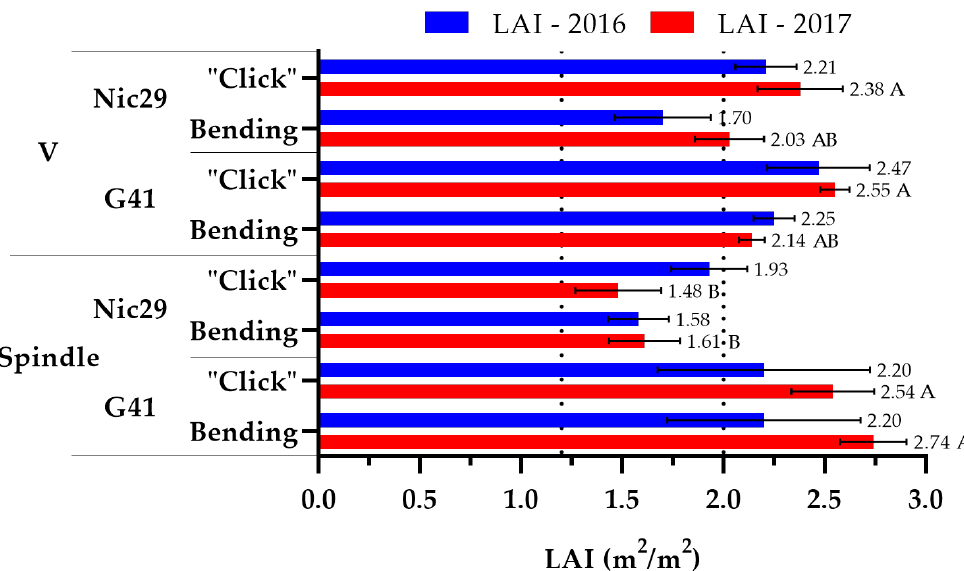
Figure 2. Average leaf area index (LAI) non-destructive estimations across all treatment combinations in the summers (June–August) 2016 and 2017 for “WA38” trees grown in Washington State. ANOVA indicated non-significant differences in 2016 (no lower-cased letters displayed) and a significance of: ** < 0.01 in 2017 (upper-cased letters). Student–Newman–Keuls (SNK) test for mean comparisons across all 8 combinations within a given year. Means to the right of each bar in the chart with the same letter indicate non-significance at p -value < 0.05. No differences among combinations in 2016, so no letters appear. Dashed vertical black lines indicate minimum and maximum optimal LAI thresholds based on literature. Errors bars ± SE, N = 3 trees. Table 2. The effects of the training system, rootstock, and pruning technique on leaf area index (LAI) (m 2 /m 2 ), light interception (LI) (%), fruit count (number of fruit/tree), yield (kg/tree), average fruit weight (g), production (MT/ha) and total production (MT/ha, 2016 and 2017) for “WA38” trees grown in Wenatchee area in Washington State in 2017.